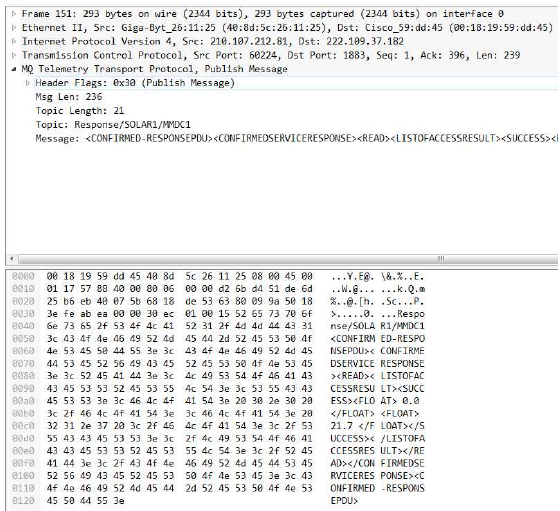
Figure 14. Packet captured from the MGMS to the DMS response message using the